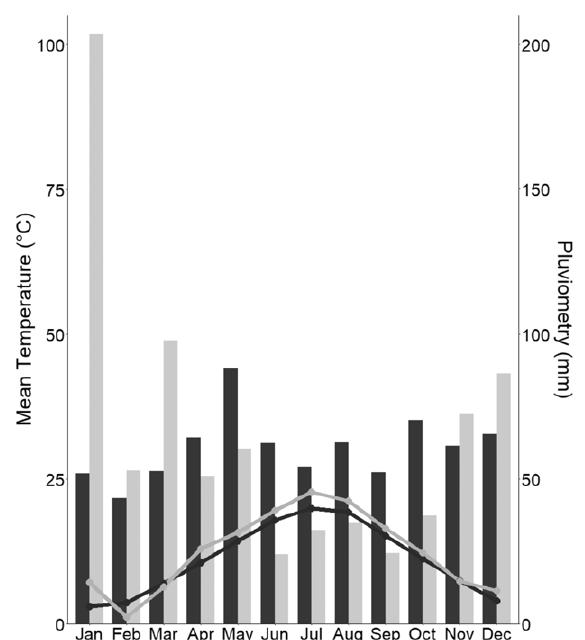
Figure 1. Ombrothermic diagram of monthly data relevant the study site showing rainfall (mm; histograms) and mean tempera- tures (°C, symbols connecting lines). Mean data for the 10-year period 2008-2017 are displayed in black, and 2018 data are dis- played in grey.